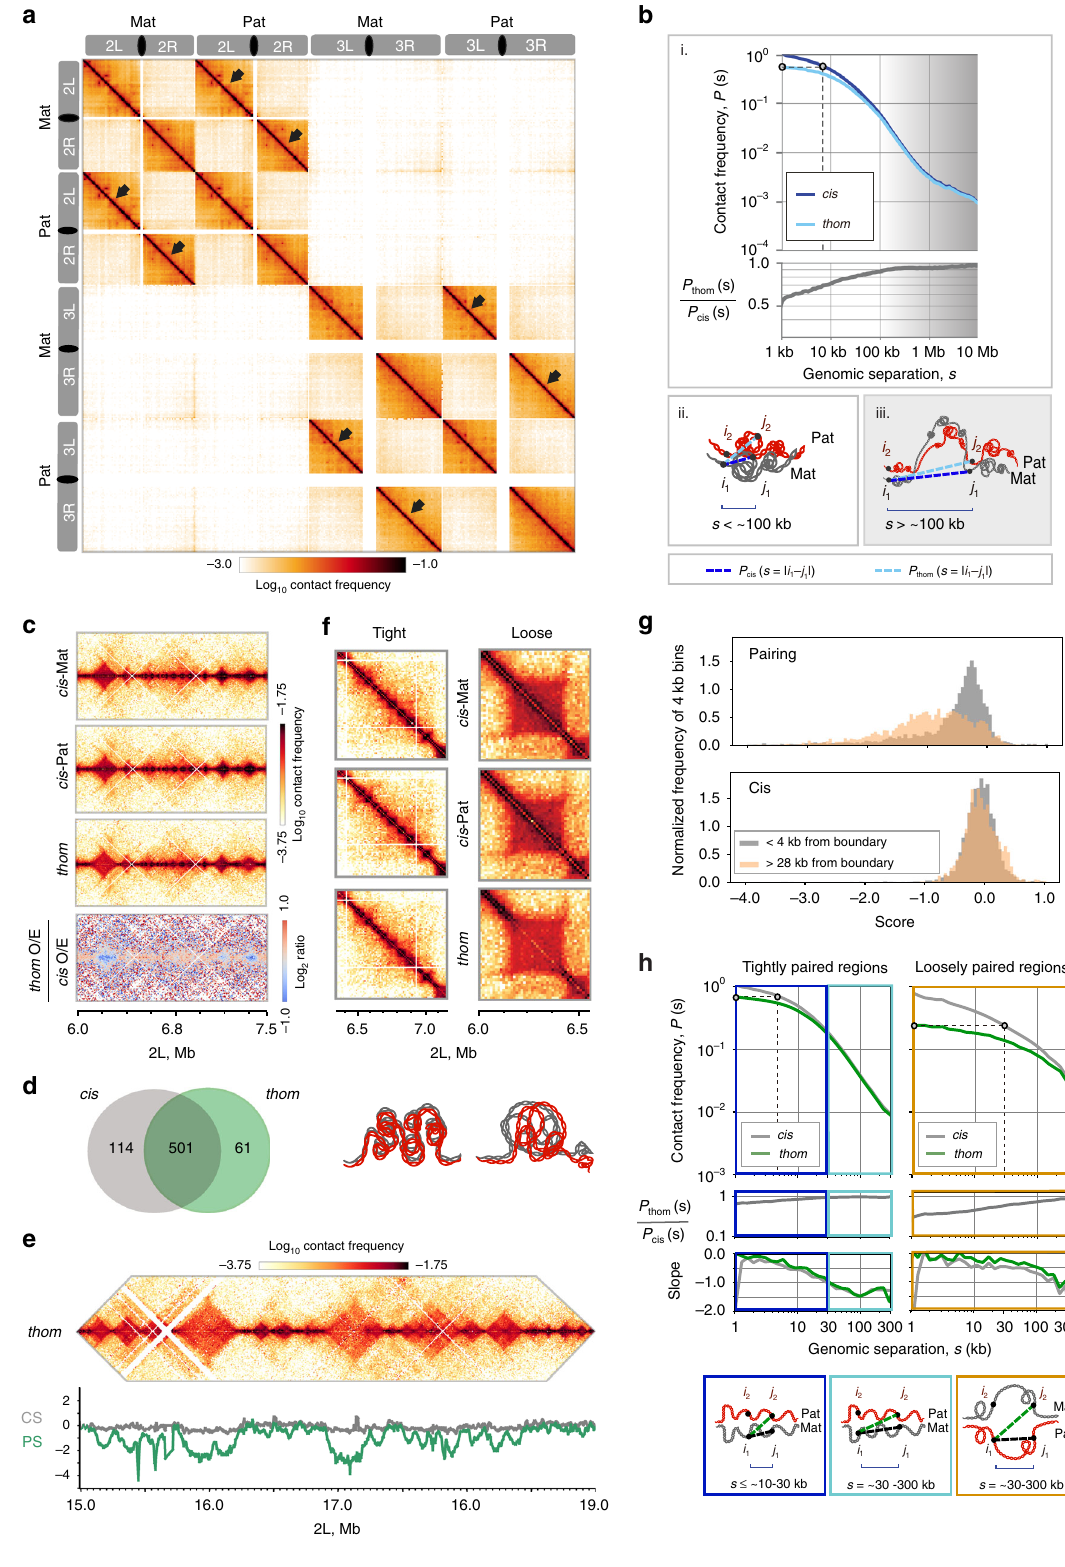
frequencies of cis and thom contacts could differ quite sub- stantially. Note that this railroad track pairing does not preclude long-range thom interactions as paired chromosomes can fold back onto themselves, behaving as a single fi